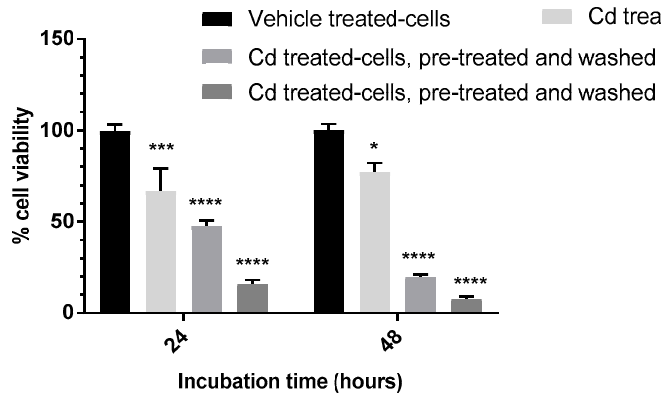
Figure 5. The anti-proliferate effect on 1321N1 cells treated with Cd with or without pre-treatment and washing-off of QE. Cells at the density of 2 × 10 4 cell/well were pre-treated with 100 or 200 µM of QE for 48 h. QE was washed off and cells were subsequently treated with Cd for 24 or 48 h. Cells cultures were then evaluated using MTT assay and the resulting absorbance values are expressed as percentages with respect to vehicle-treated cells. The bars represent mean ± SEM ( n = 8). * p = 0.0178 and *** p = 0.0002. Cd and QE bars have significant **** p values of < 0.0001.